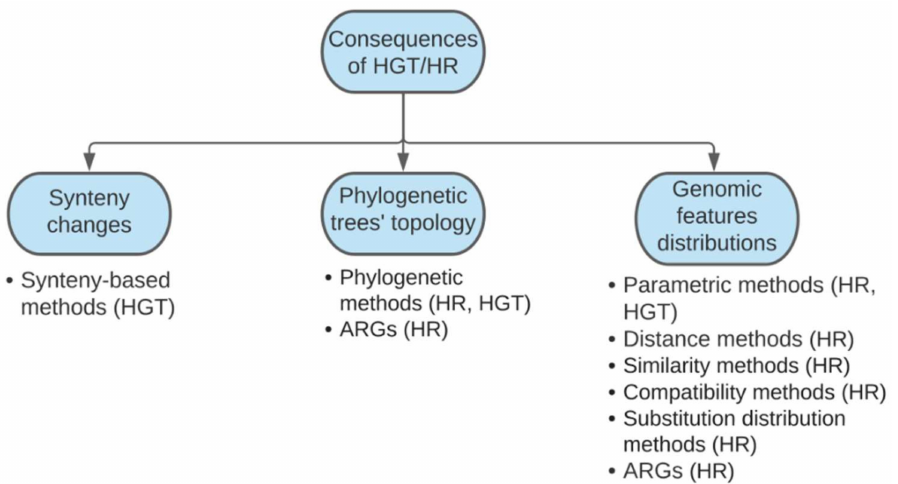
Figure 1. A combined classification of methods for detecting homologous recombination and hor- izontal gene transfer depending on the genomic consequences of the events. HR—homologous recombination, HGT—horizontal gene transfer, ARGs—ancestral recombination